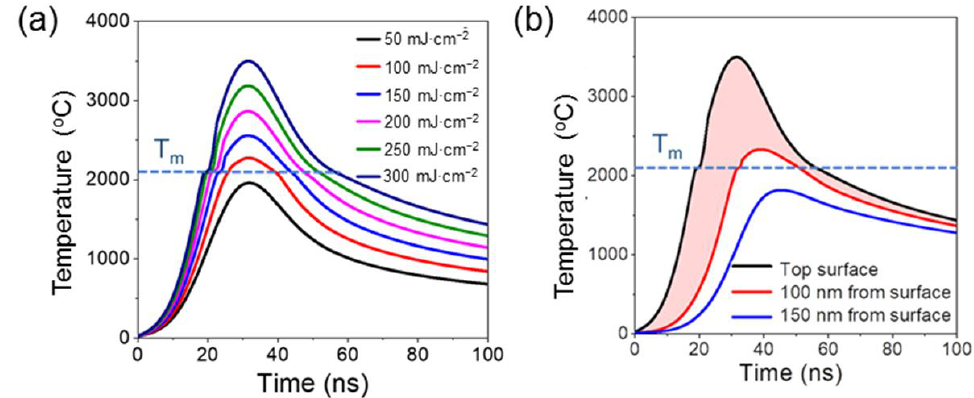
Figure 1. Numerical analysis of nanosecond pulsed laser irradiated SrTiO 3 : ( a ) temperature vs. time profiles at various laser energy densities, ( b ) temperature vs. time profiles with the change of depth for a laser energy density of 300 mJ·cm −2 .